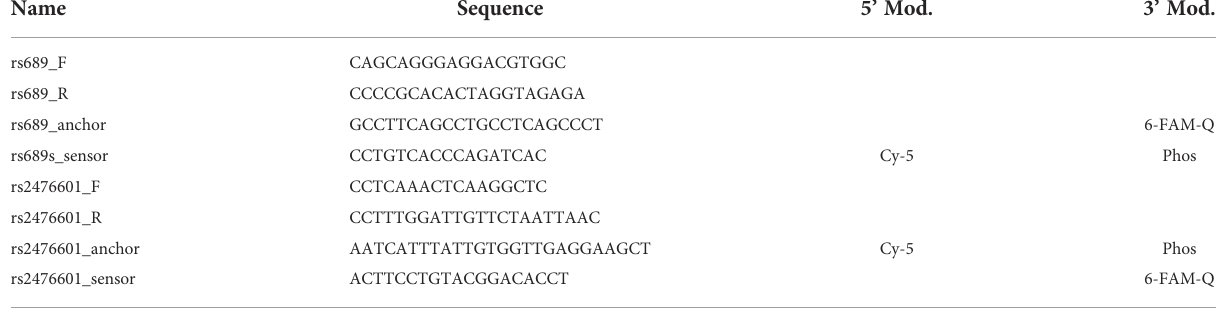
TABLE 1 Primers and probes used for INS and PTPN22